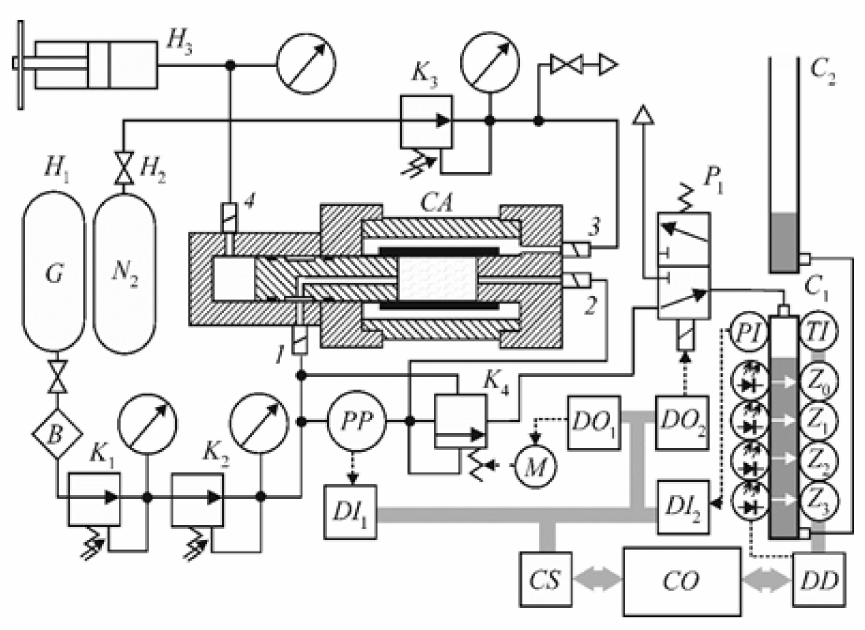
Figure 2. Function chart of the laboratory apparatus for measuring the gas permeability of rocks: H 1 and H 2 indicate the gas cylinders; H 3 indicates the hydraulic press; K 1– K 3 indicate the pressure- reducing valves; K 4 indicates the pressure valve; P 1 indicates the electrovalve; M indicates the electric drive of the pressure valve control; PP indicates the pressure difference indicator; DO 1 and DO 2 indicate the electronic control modules; DI 1 and DI 2 indicate the bridge strain gage attachment modules; Z 0– Z 3 indicate the photo sensors of liquid level gage; TI indicates the temperature sensor; PI indicates the pressure sensor; DD indicates the electronic module of the level gage; C 1 indicates the gasometer; C 2 indicates the liquid discharge vessel; CO indicates the computer; CS indicates the bus controller; CA indicates the testing cell